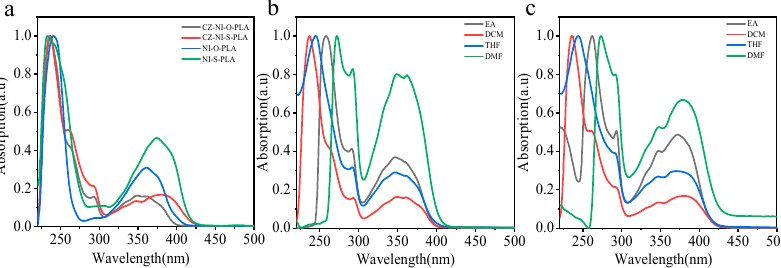
Figure 5. ( a ) UV-vis spectra of CZ-NI-O-PLA, CZ-NI-S-PLA, NI-O-PLA and NI-S-PLA, (solvent DCM); and UV-vis spectra in different polar solvents for CZ-NI-O-PLA ( b ) and CZ-NI-S-PLA ( c ).